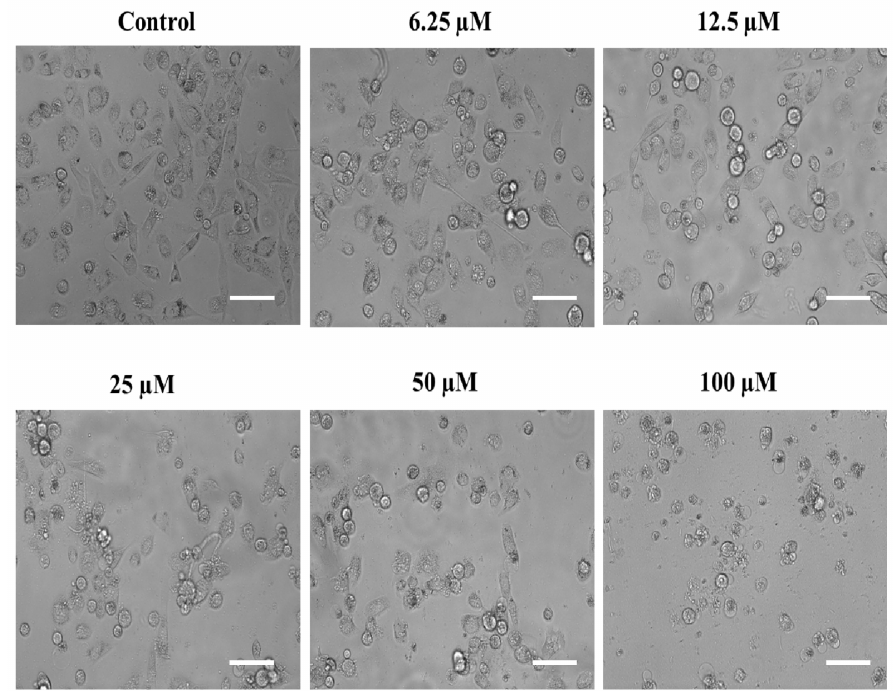
Figure 7. Phase contrast micrographs showing the impact of substituted SOX ( 4a ) on the morphologi- cal features of PC-3 cells after 24 h. For the assessment of morphological features, an equal population of the PC-3 cells was seeded in the 96-well plate and incubated with varying doses of 4a (0, 6.25, 12.5, 25, 50, and 100 µ M). Following the incubation period, photomicrographs were taken using a FLoid TM Imaging Station, Thermo Fisher Scientific, Waltham, MA, USA. Scale bar: 100 µ